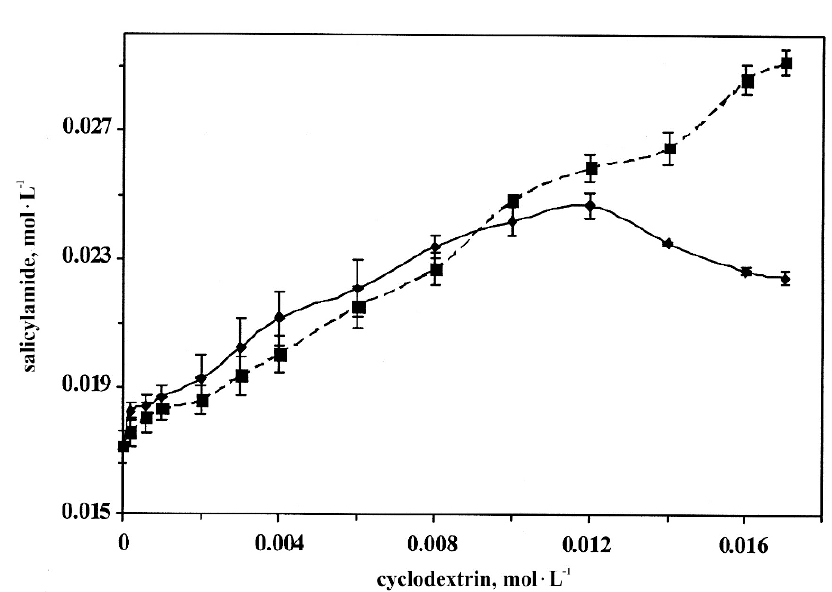
Figure 1. Phase solubility diagrams of salicylamide in the presence of β -cyclodextrin (  ) and 2-hydroxypropyl- β -cyclodextrin (---).